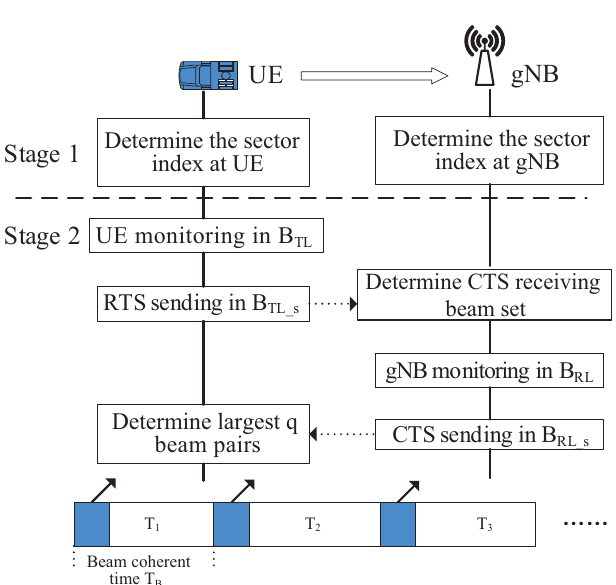
Figure 5. The procedure of trajectory prediction and channel monitoring aided fast beam tracking scheme.